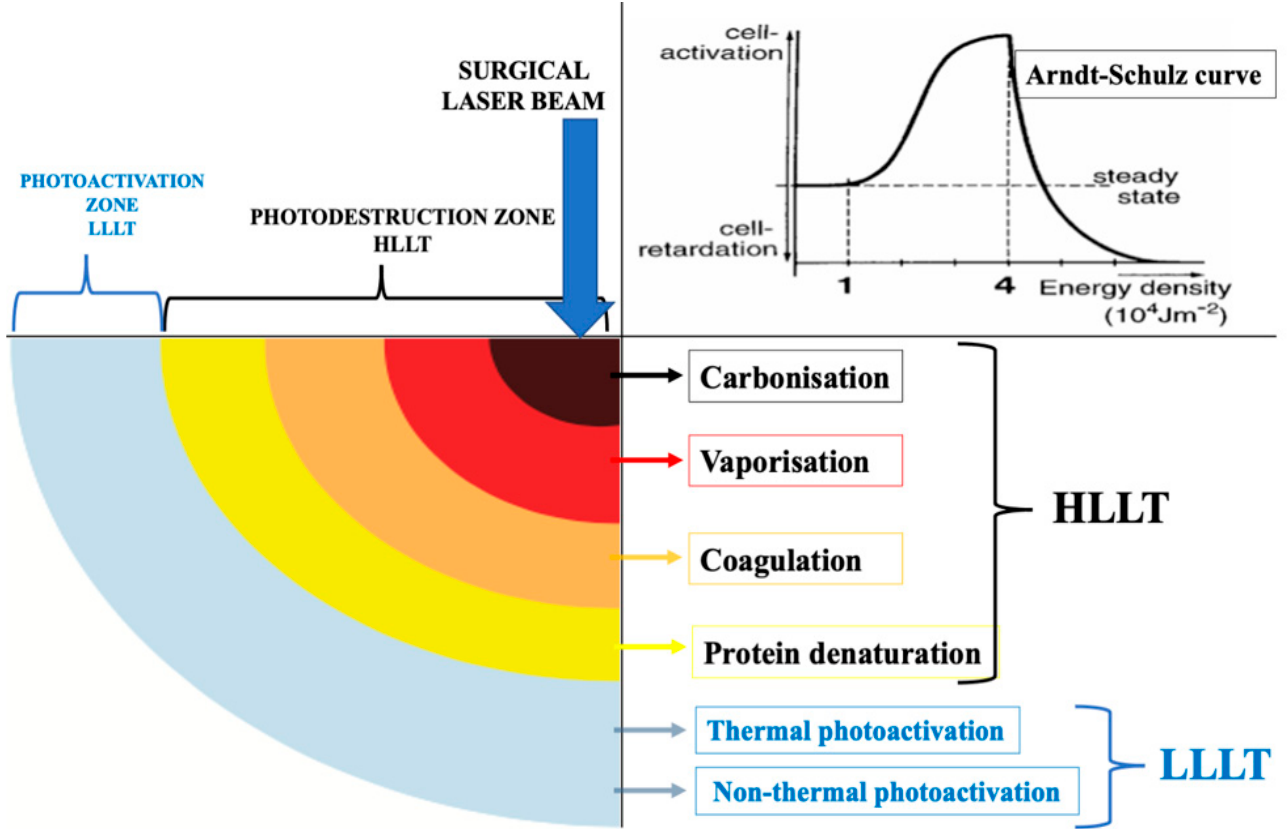
Figure 1. An illustration of the concept of the surgical laser beam profile where the photonic energy λ 940 nm, λ 2970 nm of its first zone (HLLT) is absorbed by haemoglobin (Hb) and water, respectively, which is subsequently transformed into thermal energy and then causes tissue destruction (tissue ablation), whereas the last zone of laser beam is LLLT (Modified) [13,15]. The top right graph is an “Arndt–Schulz curve”, illustrating the biphasic dose response measured in the difference in the integrated area under the curve of the time course of wound size compared to a no-treatment control, with different modes of cell reaction at different levels of energy density [17].